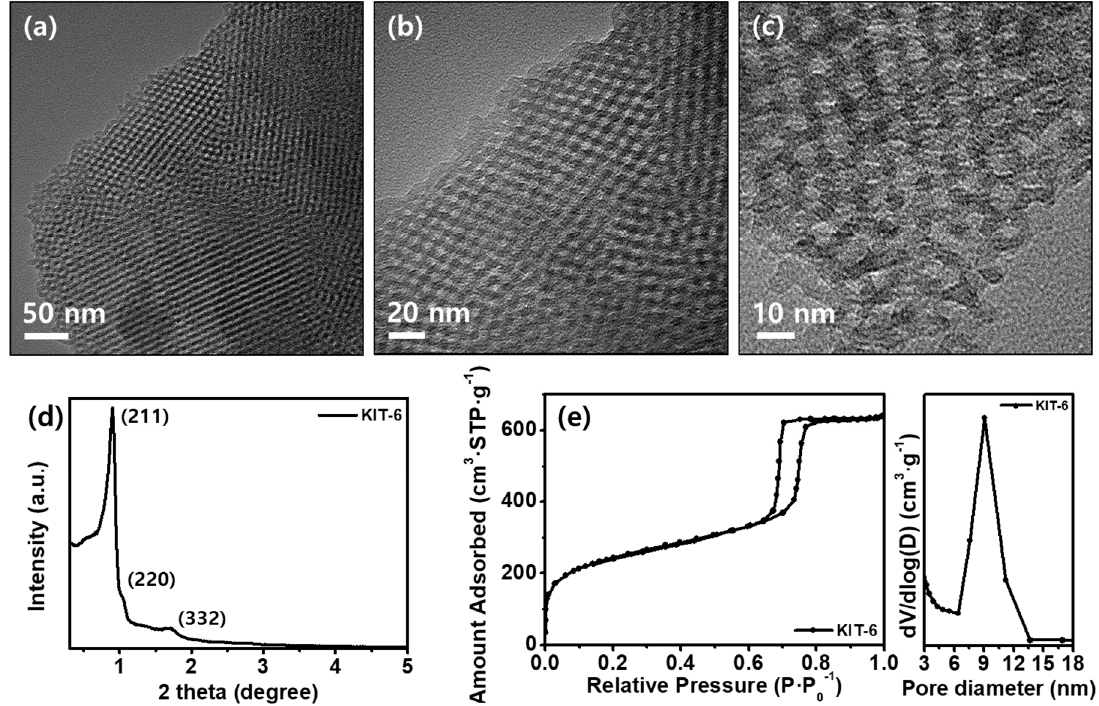
( a ) TEM image, ( b and c ) HRTEM images, ( d ) SAXS pattern and ( e ) nitrogen Figure 1. (a) TEM image, (b and c) HRTEM images, (d) SAXS pattern and (e) nitrogen adsorption– adsorption–desorption isotherm (right: pore size distribution) of the desorption isotherm (right: pore size distribution) of the KIT-6.